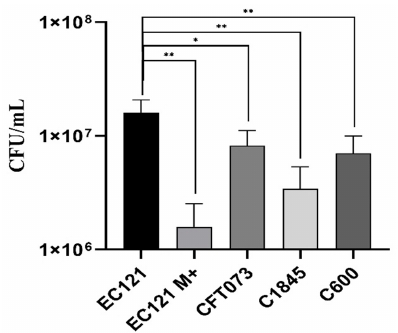
Figure 5. Quantitative adherence assay on HeLa cells. Quantitative assay performed in HeLa cells (3-h of incubation at 37 °C) in the absence of D-mannose, except when indicated.; M+, assay performed in the presence of 2% D-Mannose. The E. coli strains CFT073, C1845, and C600 were used for comparison. Experiments were done in biological duplicates and experimental triplicates. p values: * < 0.05, ** < 0.01.